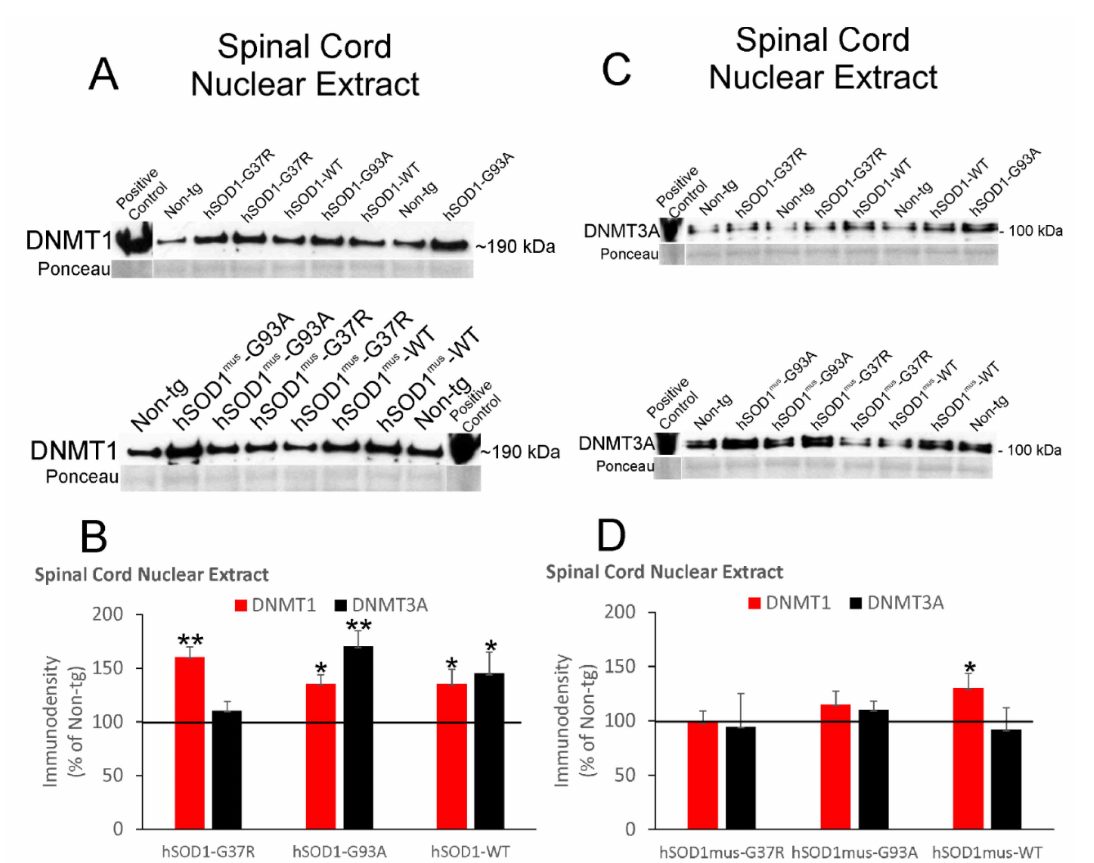
Figure 3. Immunoblotting for DNMT1 and DNMT3A in spinal cord nuclear extracts of nonconditional hSOD1 tg mice and conditional tg mice with skeletal muscle-restricted expression of hSOD1 mus . Representative blots for DNMT1 ( A ) and DNMT3A ( C ) are shown with different tg mouse lines randomized among lane assignments. Sizes of DNMT1 and DNMT3A (in kDa) are indicated for each blot at right. Each blot had a positive control lane. Ponceau S-stained membranes show protein loading. ( B ) Graph showing IR relative density levels (immunodensity mean ± SD, as % of non- tg mouse IR) for DNMT1 and DNMT3A in nonconditional hSOD1 mouse lines ( n = 5/genotype). Horizontal line designates non-tg control at 100%. * p < 0.05; ** p < 0.01. ( D ) Graph showing protein